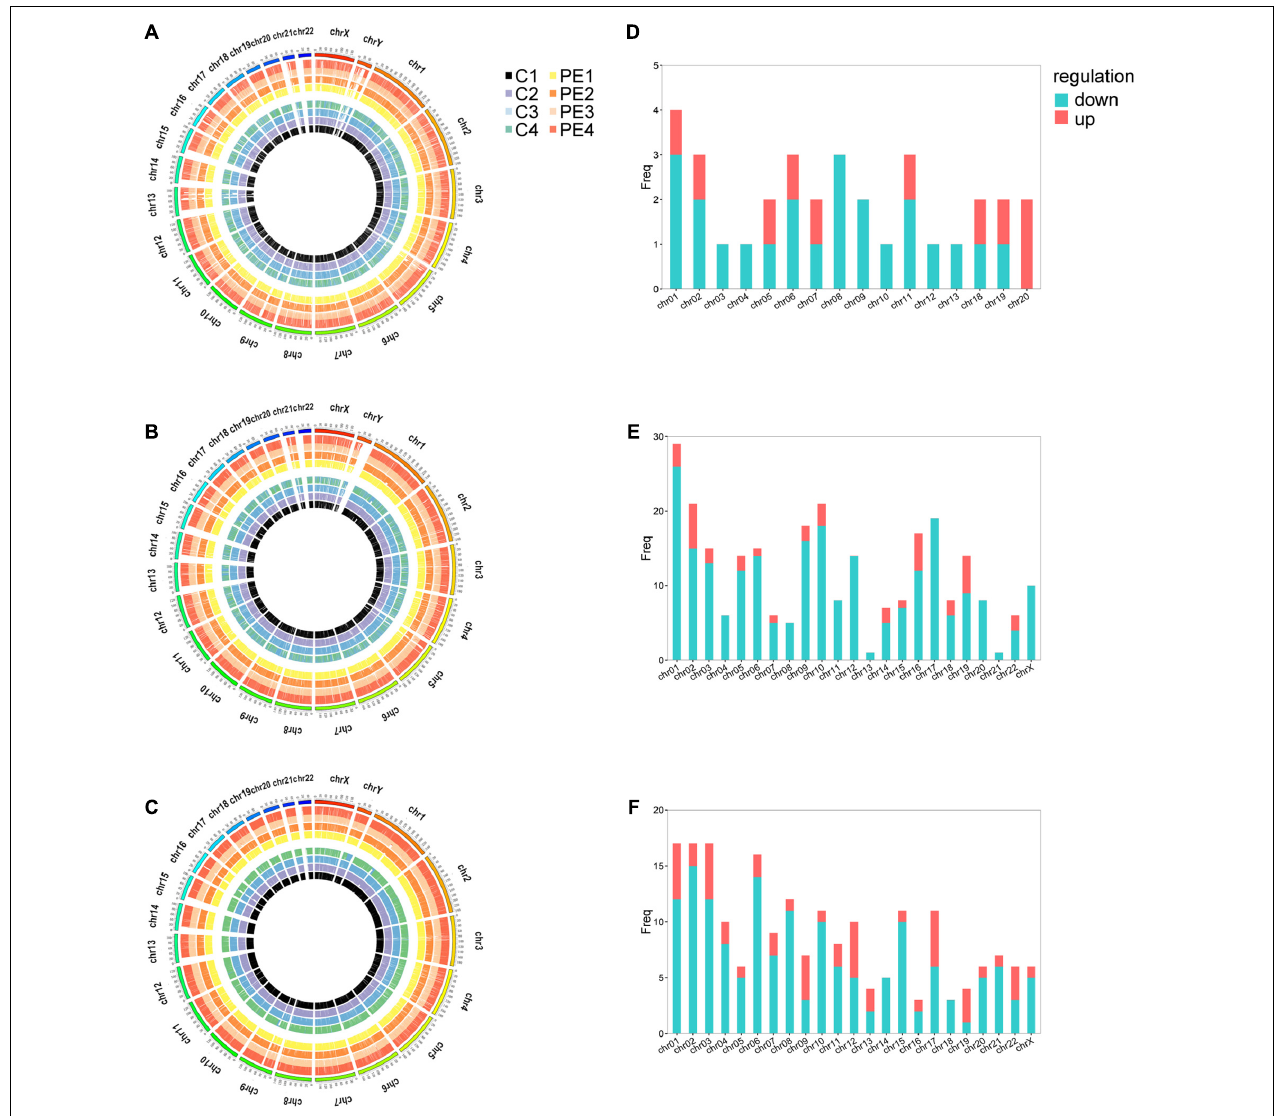
FIGURE 2 | The distribution of DERNAs on chromosomes. Circos plot of genome-wide mRNAs (A) , circRNAs (B) , and lncRNAs (C) . Histograms depict the distribution of DEmRNAs (D) , DEcircRNAs (E) , and DElncRNAs (F) mapped on each chromosome. The outermost circle represents the human chromosomes, while the inside eight circles represent eight samples from control and PE patients. The Y -axis denotes the count of transcripts mapped to the chromosome. CON, control; PE, preeclampsia, n =